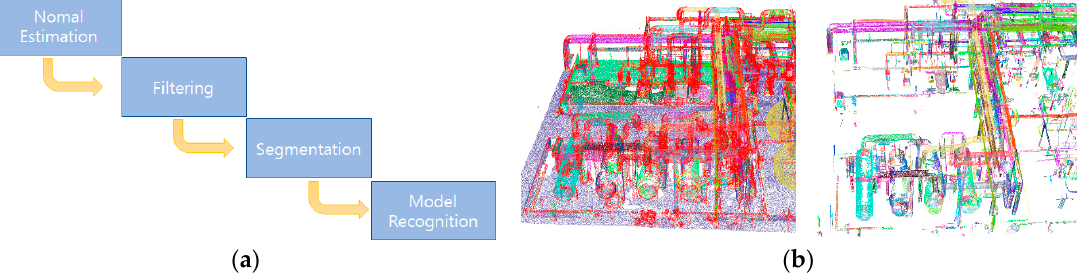
Figure 1. ( a ) Model recognition preprocessing process; ( b ) region growing segmentation [1].